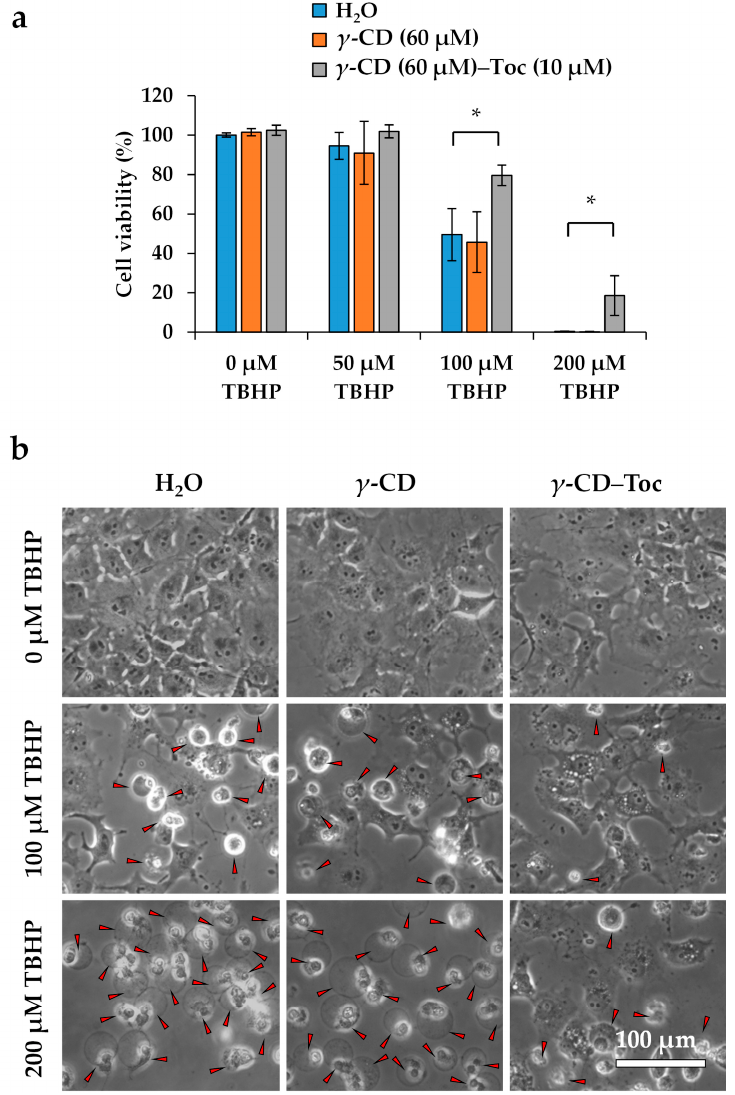
Figure 5. Cytoprotective impact of the γ -cyclodextrin (CD)-vitamin E (Toc) complex in the presence of a cytotoxic oxidative stressor. ( a ) Viability of COS-7 cells cultured for 30 min in the presence or absence of γ -CD or γ -CD-Toc before exposure to 0, 50, 100, or 200 µ M tert -butyl hydroperoxide (TBHP) for 18 h. Cell viability was measured using a Cell Counting Kit-8 (Dojindo Laboratories) (* p < 0.05). ( b ) Phase-contrast photomicrographs of COS-7 cells cultured for 30 min in the presence or absence of γ -CD or γ -CD-Toc before exposure to 0, 100, or 200 µ M TBHP for 18 h. The red arrowhead indicates a dead cell.